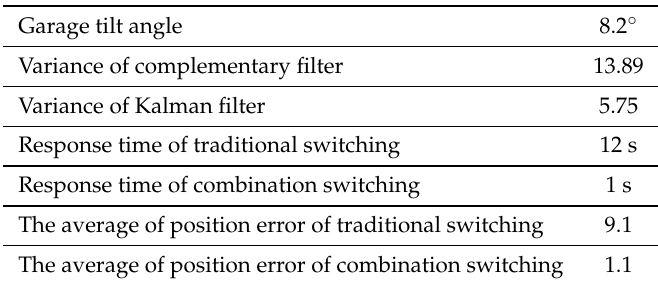
Table 1. Statistics of system experimental data.